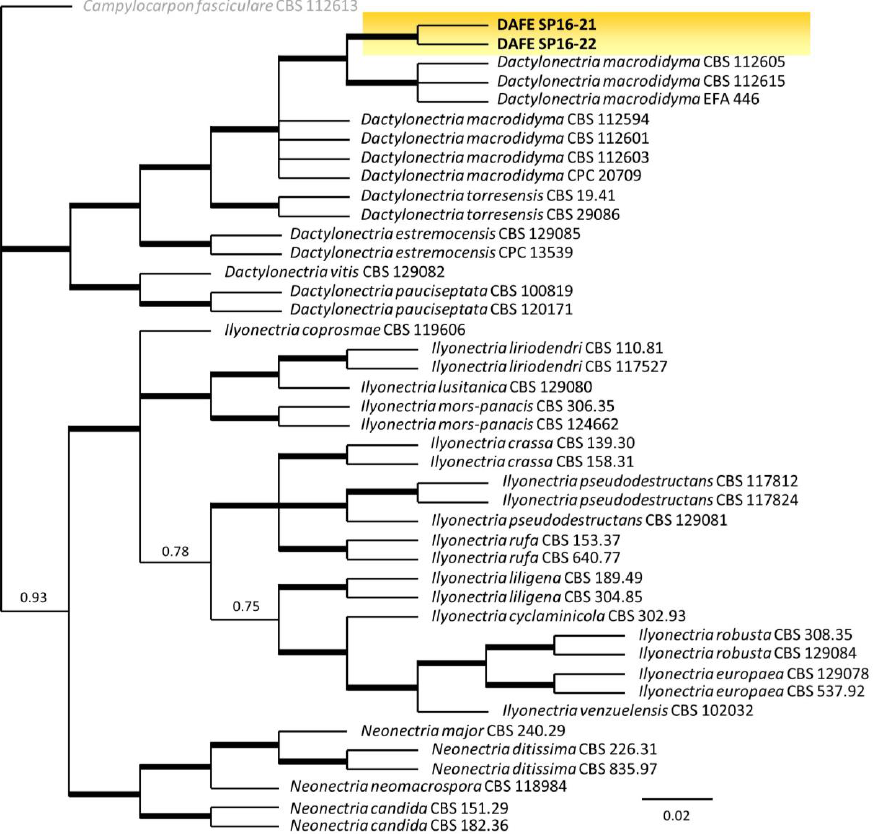
Figure 4. Bayesian inference phylogenetic tree generated using concatenated sequences of HIS3 , TUB2 and ITS. A GTR + G + I evolution model was used for HIS3 sequences, while a K2 + G evolution model was selected for ITS and TUB2 sequences. The representative isolates DAFE SP16-21, and DAFE SP16-22 are highlighted in yellow. The values above branches show Bayesian Posterior Probability (BPP). Thicker branches represent nodes with BPP ≥ 0.95. The scale bar indicates the number of expected substitutions per site. Campylocarpon fasciculare (CBS 112613) was used as an outgroup.